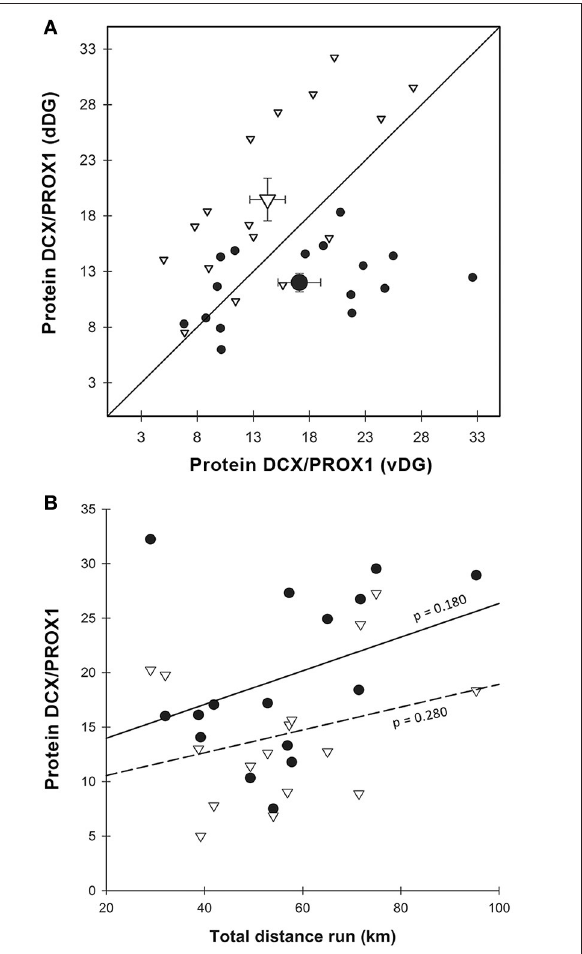
FIGURE 4 | Dcx gene expression. (A) When normalized on Prox1 , Dcx was increased in E-dDG compared to C-dDG (GEE, p = 0.033) but decreased in E-vDG compared to C-vDG (GEE, p = 0.002). Both C-vDG and E-vDG were significantly different from C-dDG (GEE, p < 0.001) and E-dDG was different